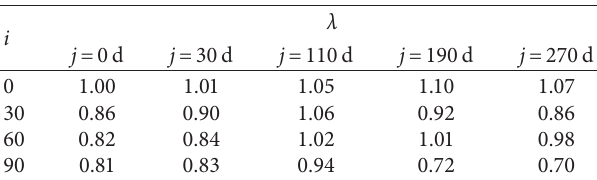
Figure 14: Pore size distribution of C3-7 under coupled corrosion and freezing-thawing environment. Table 3: Composite strength impact factor λ with the freezing- thawing cycles i and corrosion time j of